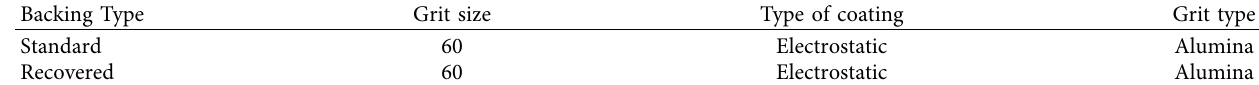
Table 3: Characteristics of coated abrasive discs for the current experiment